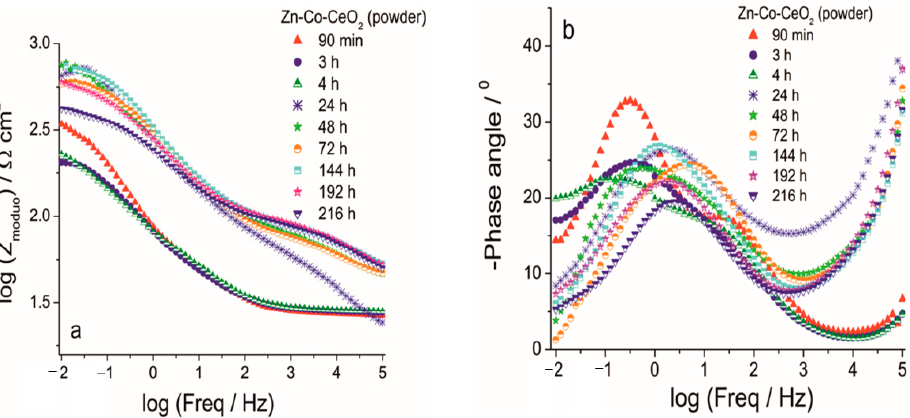
Figure 13. The Bode ( a ) modulus and ( b ) phase angle plots for Zn-Co-CeO 2 (CeO 2 powder) coating during exposure to NaCl solution.